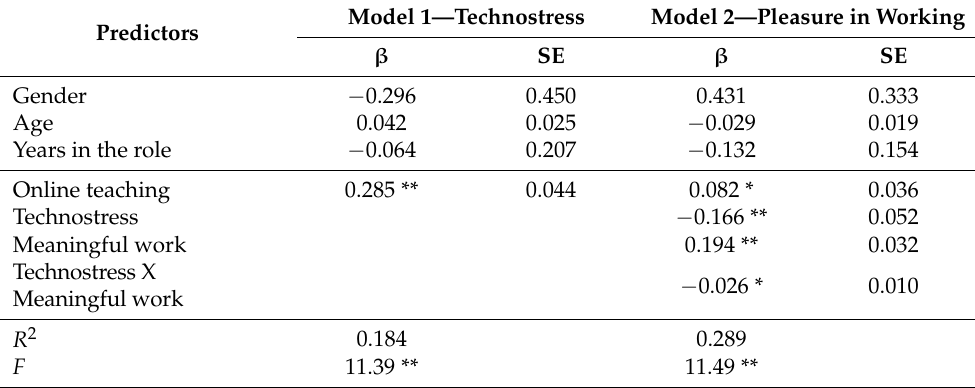
Table 3. Moderated mediation effects (N = 219).